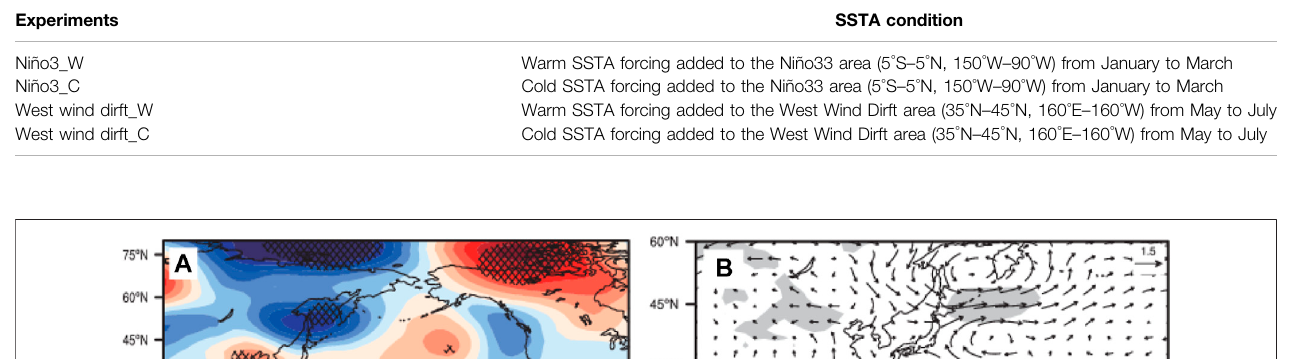
TABLE 3 | Design of numerical experiments. Experiments SSTA condition